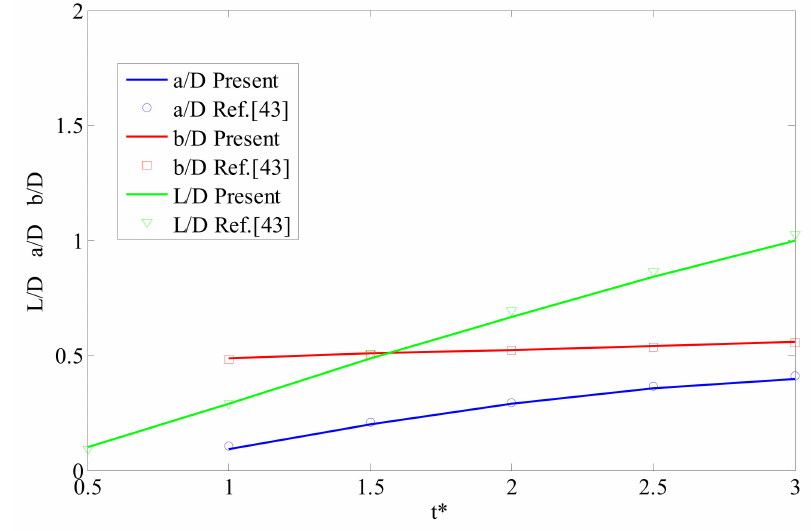
Figure 6. The comparison of the length of the wake and the coordinate of the eddy center between the present results and the results of Reference [43] for Re =